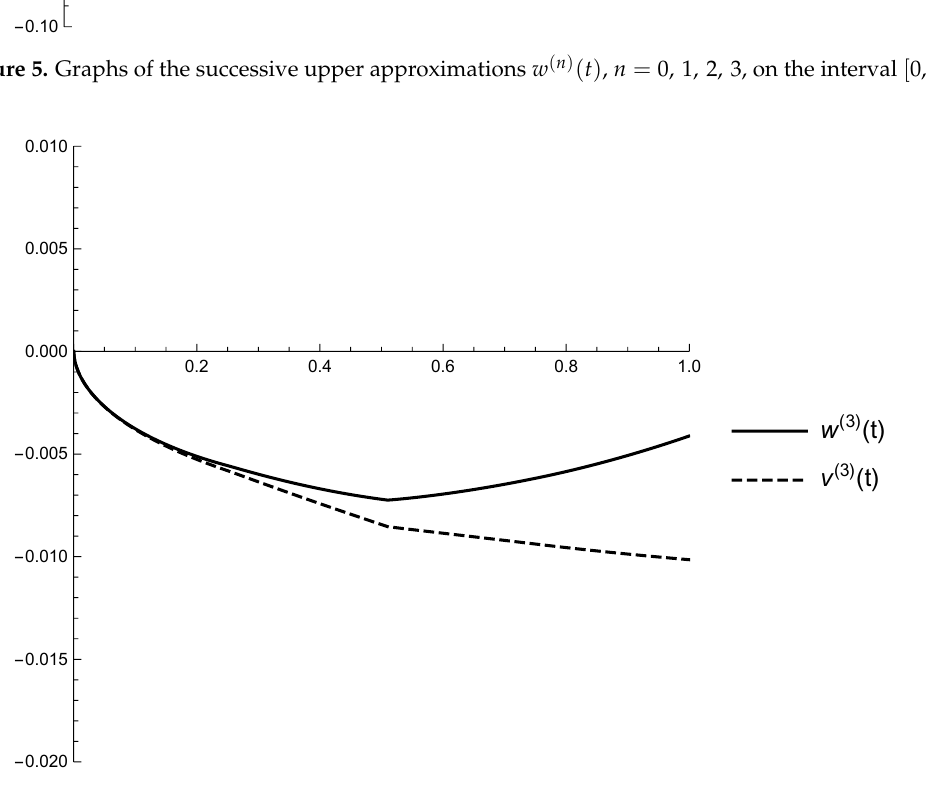
Figure 6. Graphs of the successive approximations v ( 3 ) ( t ) and w ( 3 ) ( t ) on the interval [ 0,1 ]